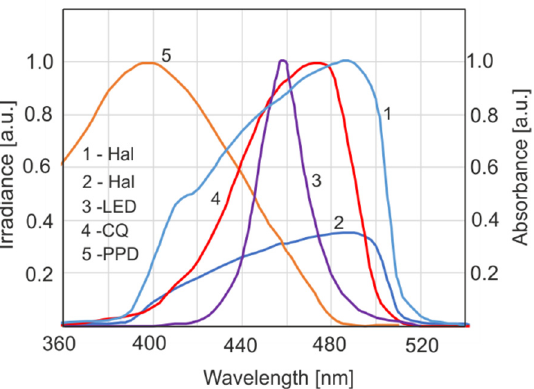
Figure 4. Normalized emission spectra of light sources (1,2,3) and absorption of activators (4,5). The values for curves 2 and 3 are such that the areas represent the same total power.